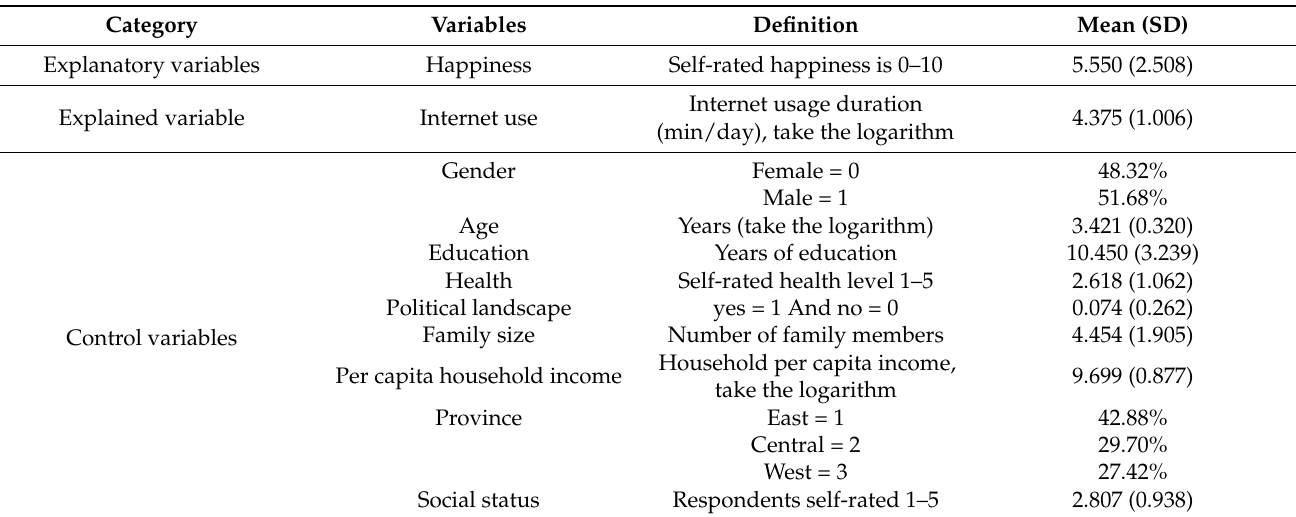
Table 1. Descriptive statistics for regression